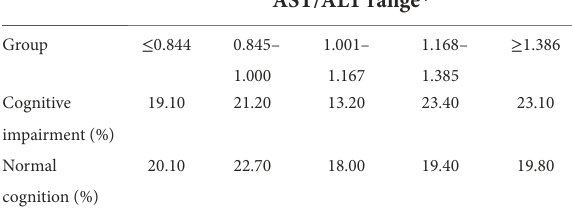
TABLE 2 Chi square test analysis results of the different range of